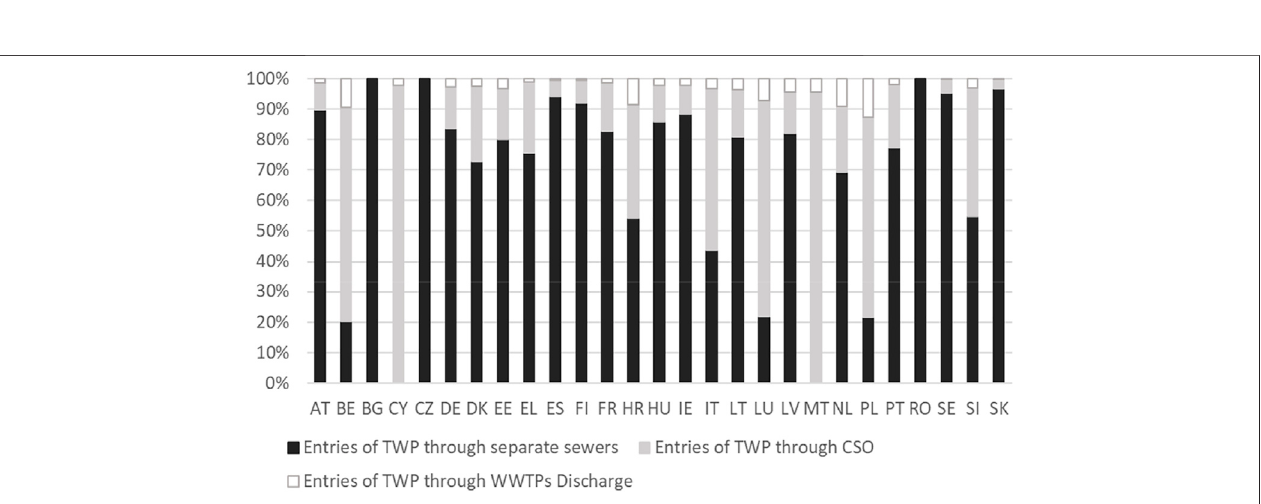
Frontiers in Environmental Science |